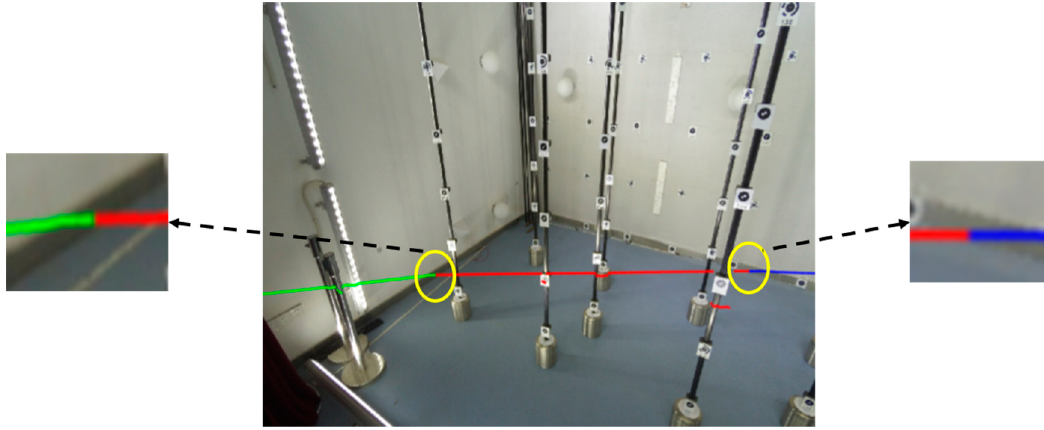
Figure 15. Projection of LRF range data on the image using the extrinsic parameters calibrated by our scheme.